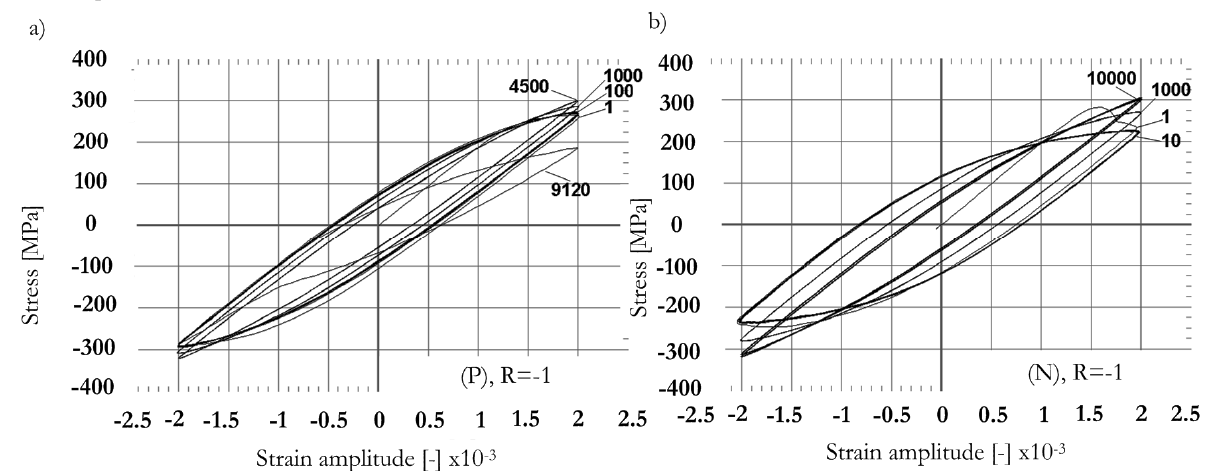
Figure 5: ( a) Coffin-Manson curve for puddled steel in post-operating state, (b) Coffin-Manson curve for puddled steel in normalized state for puddled steel [6].